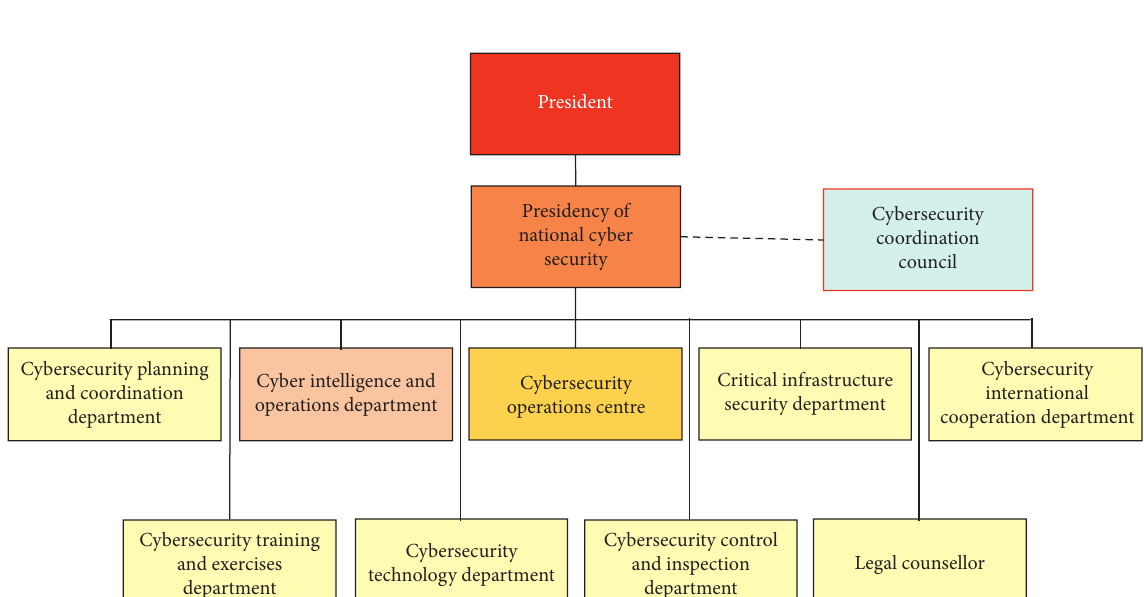
Figure 11: Proposal for structuring of national cyber security presidency.